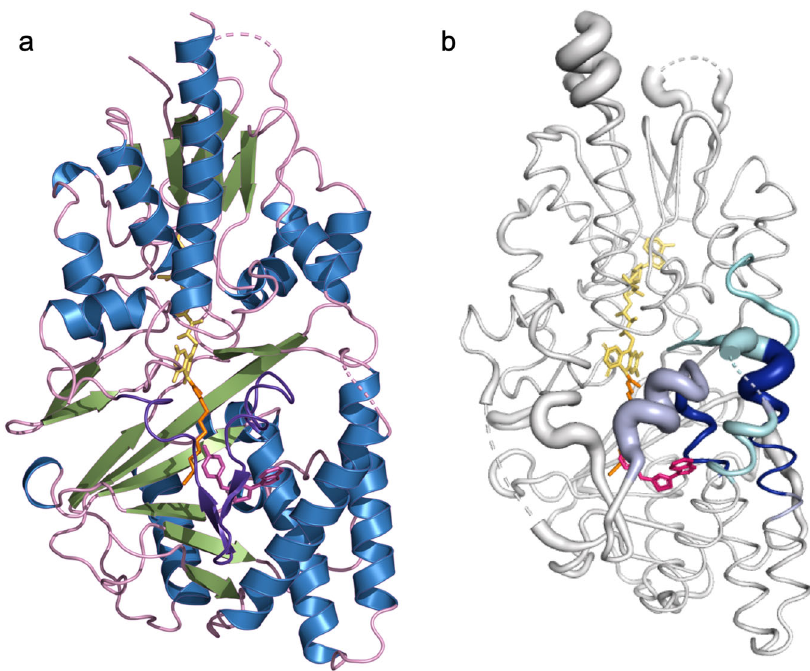
Fig. 6 Structure of ehSMOX containing the ligand JNJ-1289 and HDX-MS of the complex. a Structure of ehSMOX in ribbon representation. The FAD cofactor is shown in yellow, MDL72527 in orange and the ligand JNJ-1289 is shown in magenta sticks; the loop in front of the substrate-binding pocket is in purple color. b HDX-MS signatures differences between hSMOX and hSMOX bound to JNJ-1289 overlaid onto a putty representation (areas with increased diameter correlate with higher B-factors) of ehSMOX; decreased deuterium uptake upon JNJ-1289 binding, is depicted with a color spectrum from cyan to blue with increased